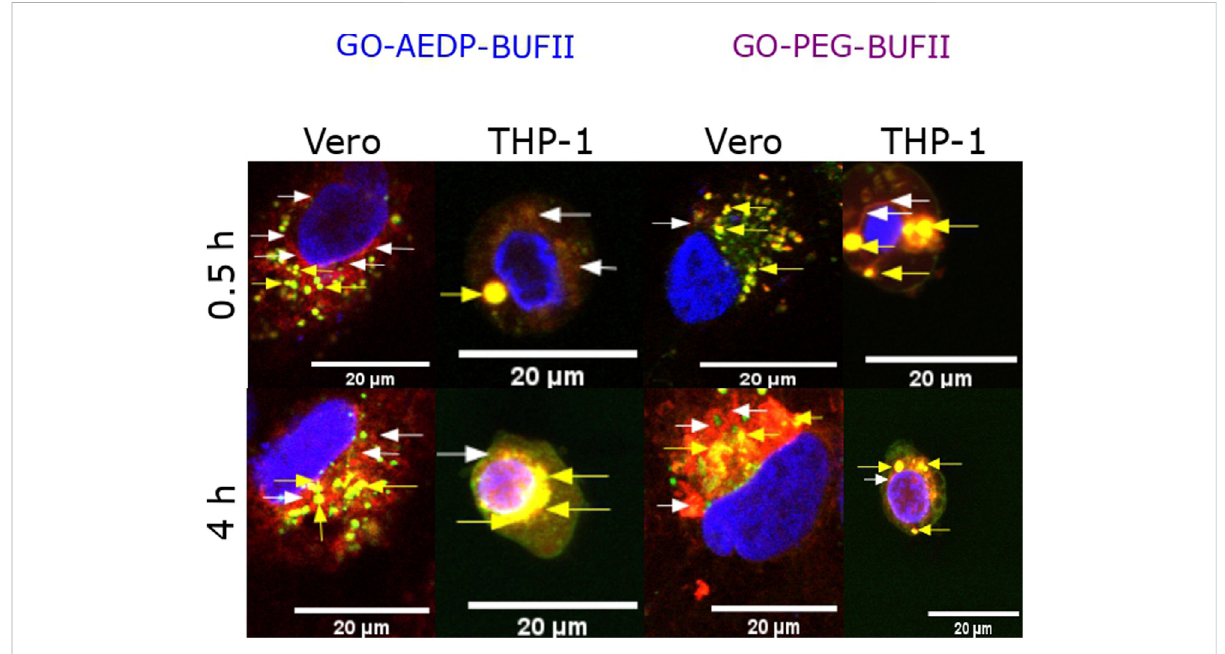
FIGURE 5 Visual inspection of colocalization studies via confocal imaging. Yellow arrows show the colocalization between the nanobioconjugates (red channel) and endosomes (green channel). White arrows show the absence of colocalization (nanostructures escaping from